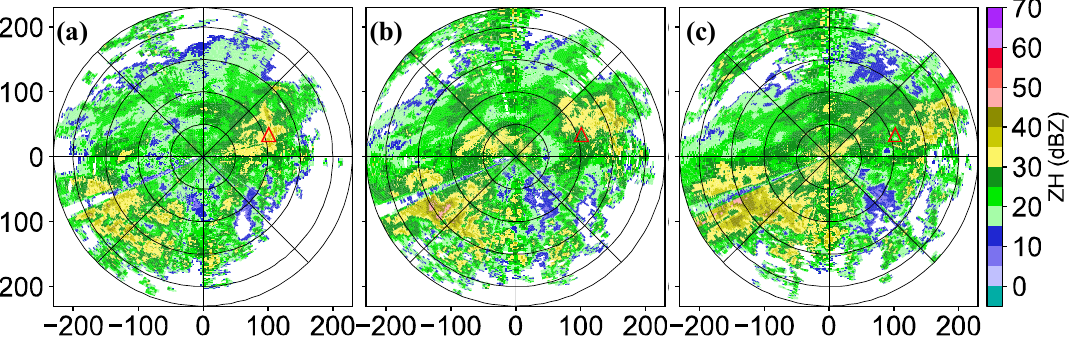
Figure 12. The 0.5° PPI of reflectivity of the Hefei radar at 0818 ( a ), 0914 ( b ), and 0949 LST ( c ) on 24 November 2015, in which the red triangle is the location of the disdrometer at ChuZhou.